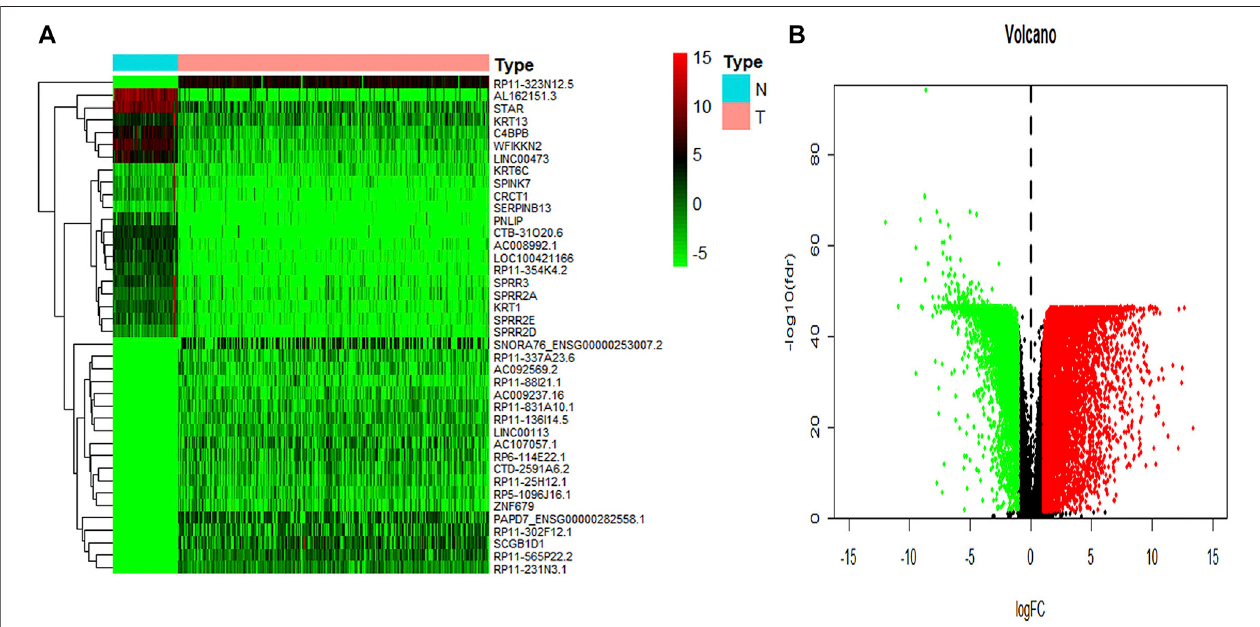
FIGURE 3 | The summary of differential expression genes in ovary cancer samples vs. controls. (A) The heatmap shows the top 50 differentially expressed genes. (B) The volcanoshows alog-fold change of expression ofeach gene. The red dots represent the up-regulated genes and the green ones represent the down-regulated genes. The black dots represent the gene without signi fi cant differential expression in cancer vs.